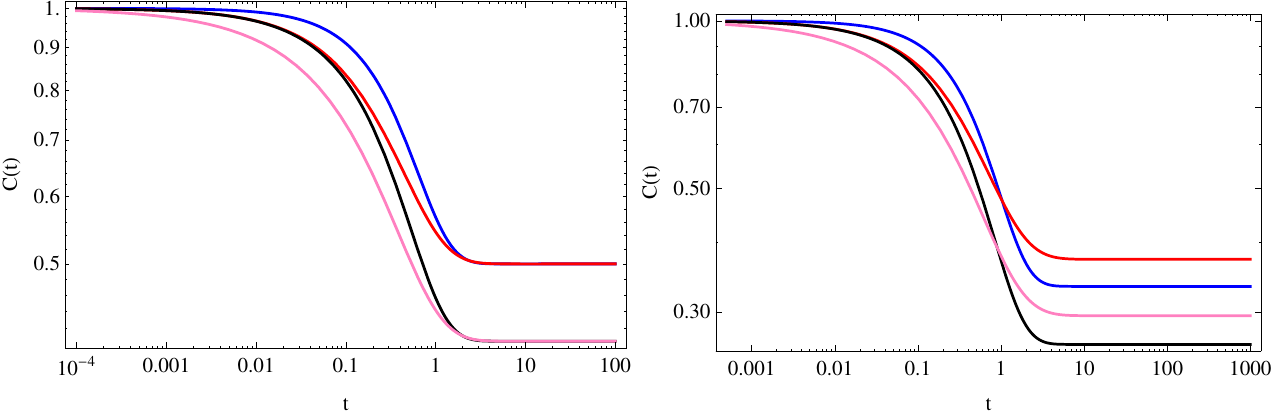
Figure 10. Behaviour of the correlation function (80) for the Havriliak–Negami relaxation in the presence of resetting. The parameters are taken as follows: λ 1 = 1, τ = 1, and α = ν = 1 (Debye relaxation with resetting, blue line), α = 3/4, ν = 1 (red line), α = 1, ν = 3/4 (black line), α = ν = 3/4 (pink line). Left panel : r = 1; Right panel : r =